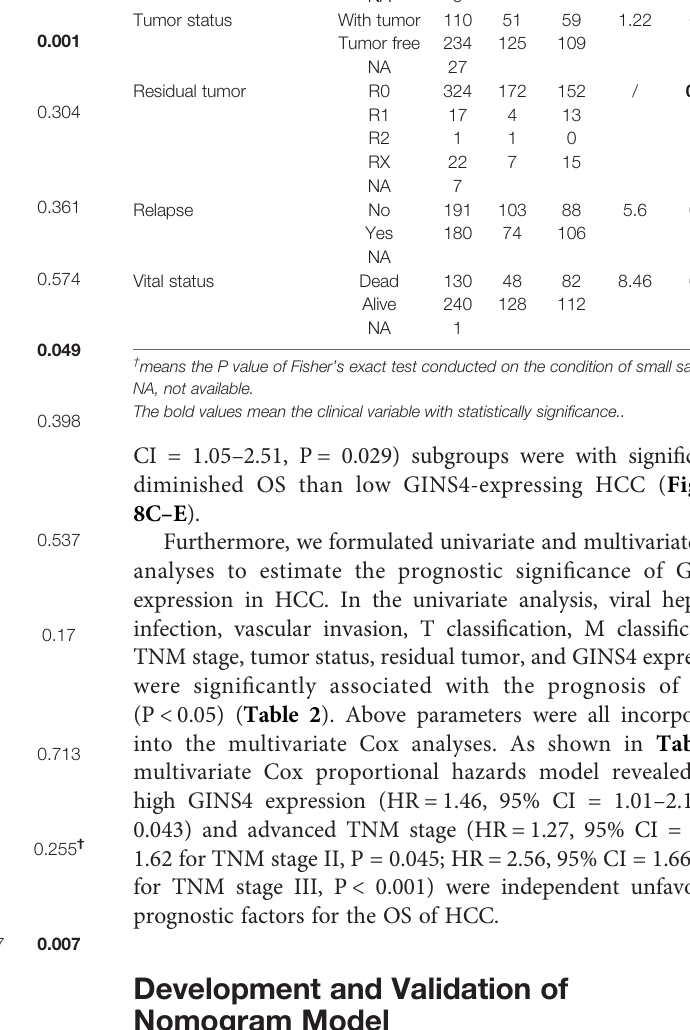
Figure 9A , TNM stage and GINS4 mRNA level made great